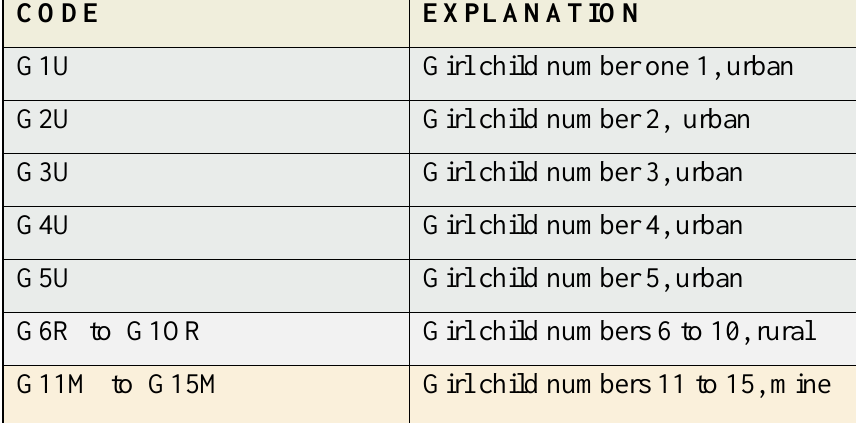
Table 5.1: Codes of individual interviews: girl learners